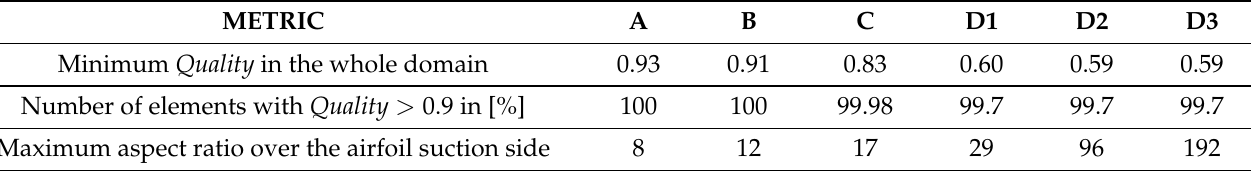
Figure 2. Mesh resolution analysis; A, B, C, D1, D2 and D3 are the tested grids with more detailed information given in Table 1. Note that for all panels, the convergence is monotonic in terms of total mesh cells. Table 1. Mesh quality analysis; Quality ranges from 0 to 1 for the worst and the best quality,